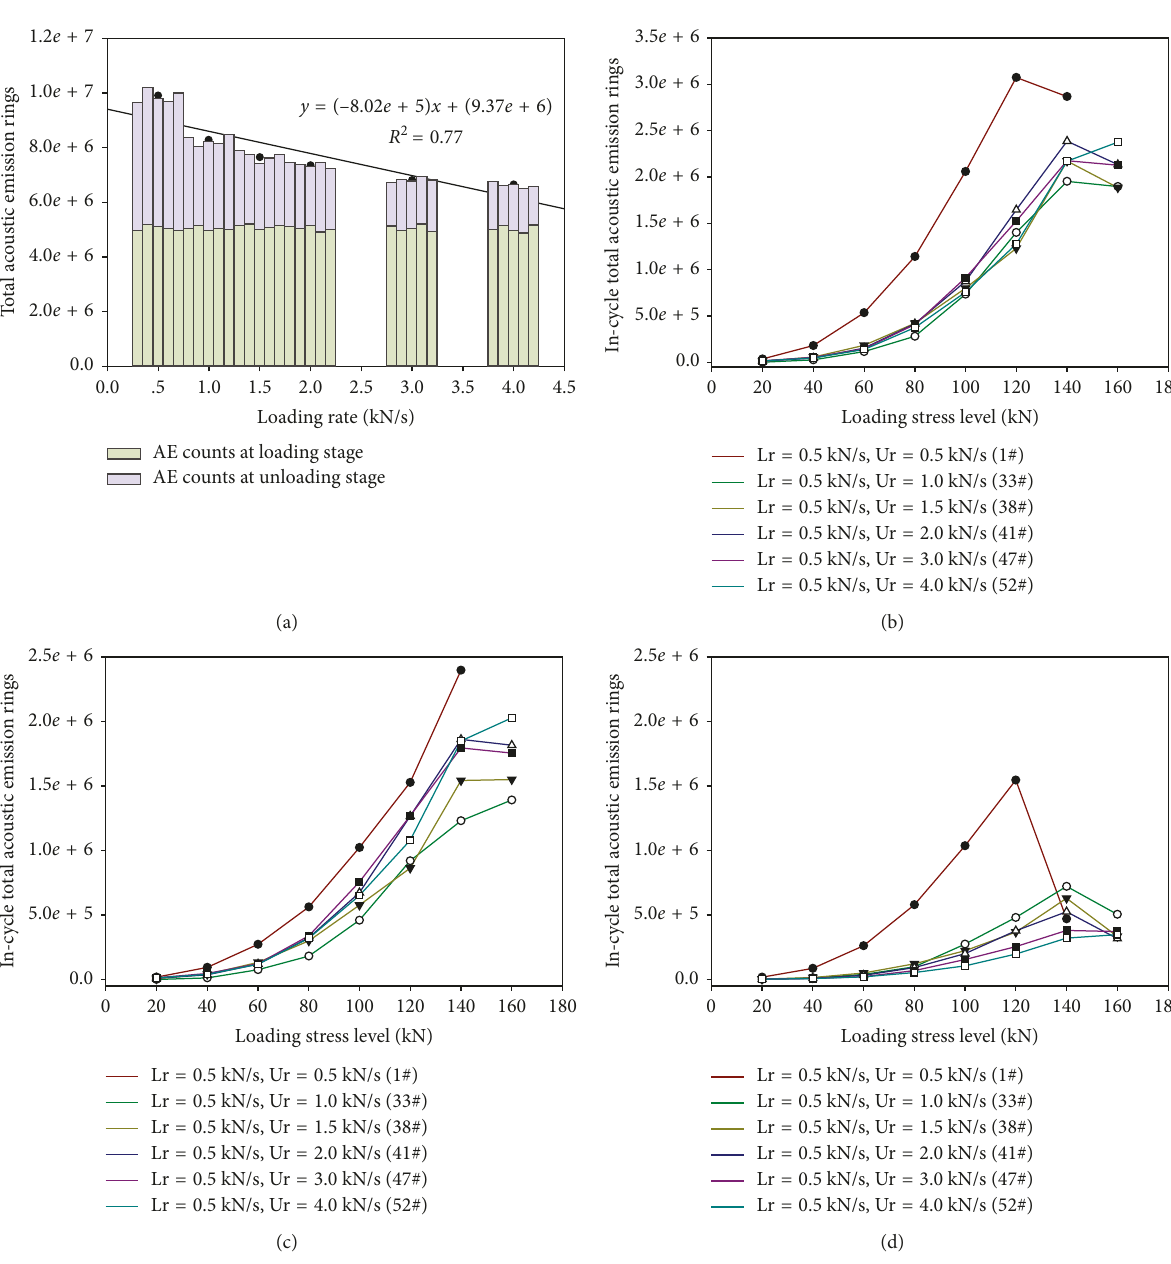
0.5kN/s, Ur 0.5kN/s ∼ 4.0kN/s). (a) Total AE rings versus (cid:30) (cid:30)